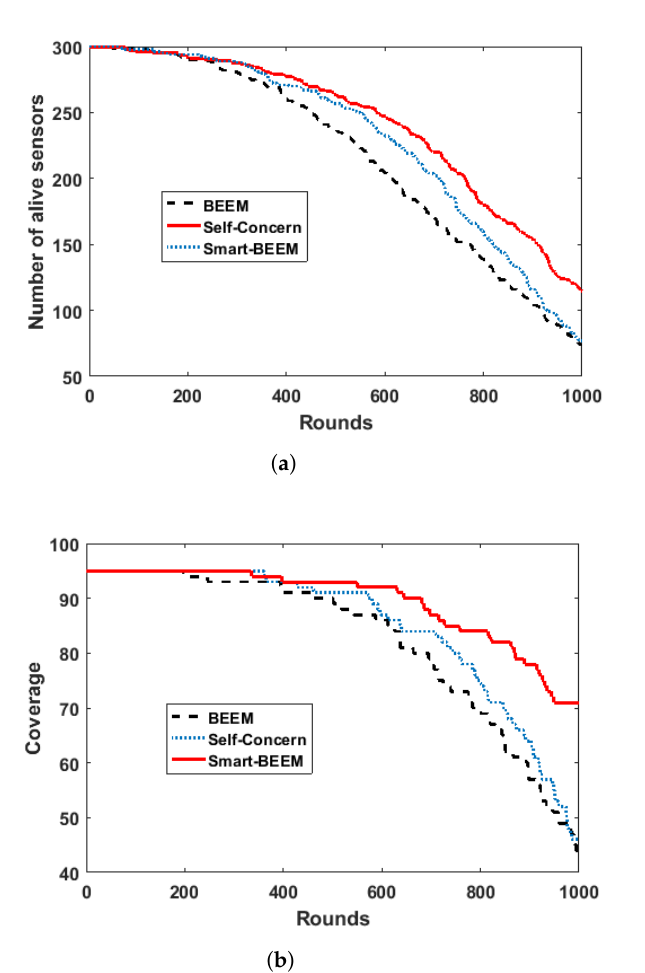
Figure 10. Comparison between BEEM, Self-Concerned and Smart-BEEM. ( a ) Number of sensors still alive; ( b ) network